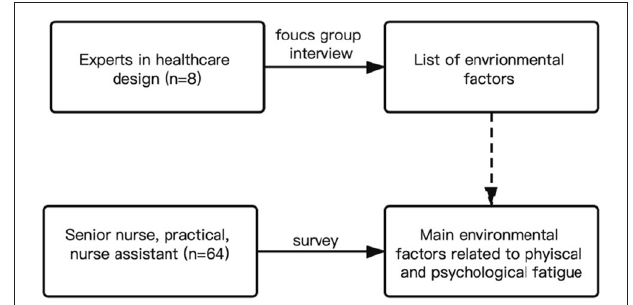
FIGURE 1 | Conceptual research